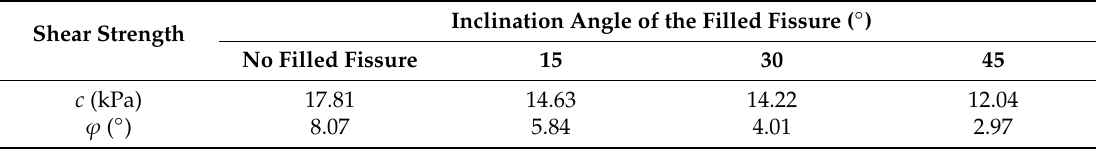
Figure 8. Shear strength fitting results of the triaxial test. ( a ) Without a filled fissure; ( b ) filled fissure with an inclination angle of 15°; ( c ) filled fissure with an inclination angle of 30°; ( d ) filled fissure with an inclination angle of 45°. Table 3. Shear strength results of the triaxial test.